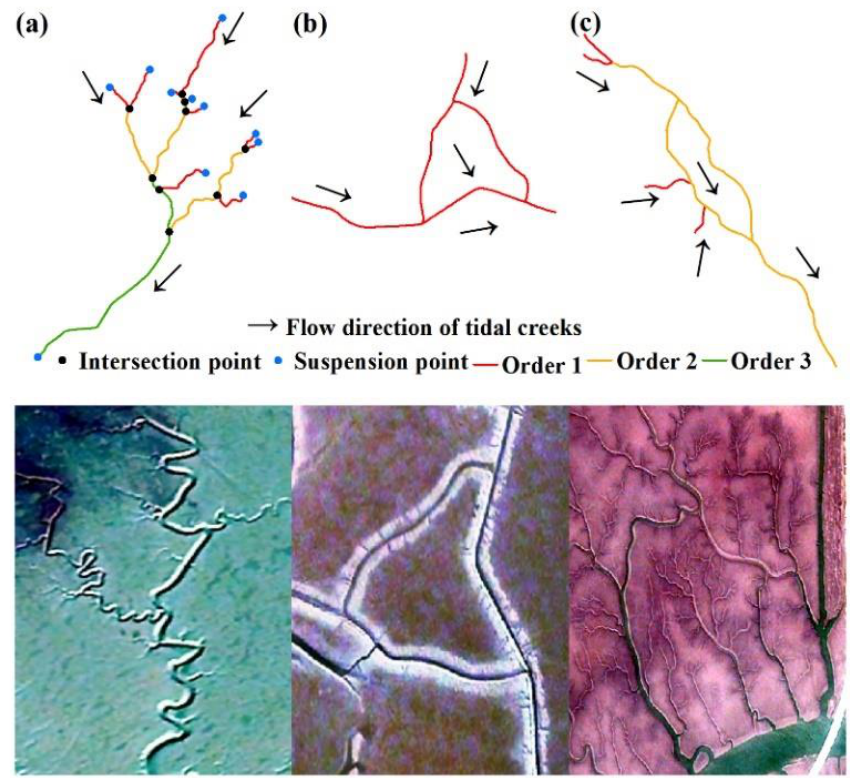
Figure 6. Flow chart of tidal creek ordering. (( a ): The tree-shaped tidal creek and ( b , c ): The island- shaped tidal creek.). Table 2. Morphological parameters of tidal creeks in the LRE and the formulas for calculating the parameters.